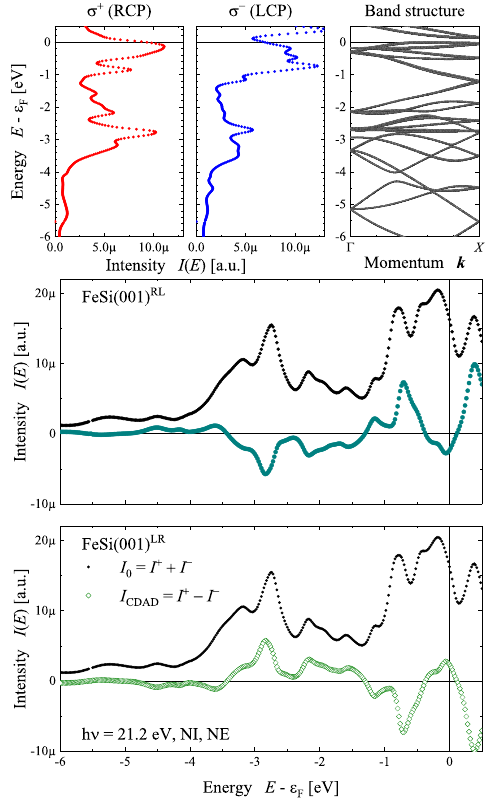
Figure 19. Polarization dependent photoelectron spectra and CDAD from FeSi(001). The polarization- dependent spectra are shown in comparison to the band structure along ∆ for one of the enantiomers. The calculations are for normal incident photons of 21.2 eV energy and opposite helicity. For the enantiomorphous pair, the resulting circular dichroism is compared to the total